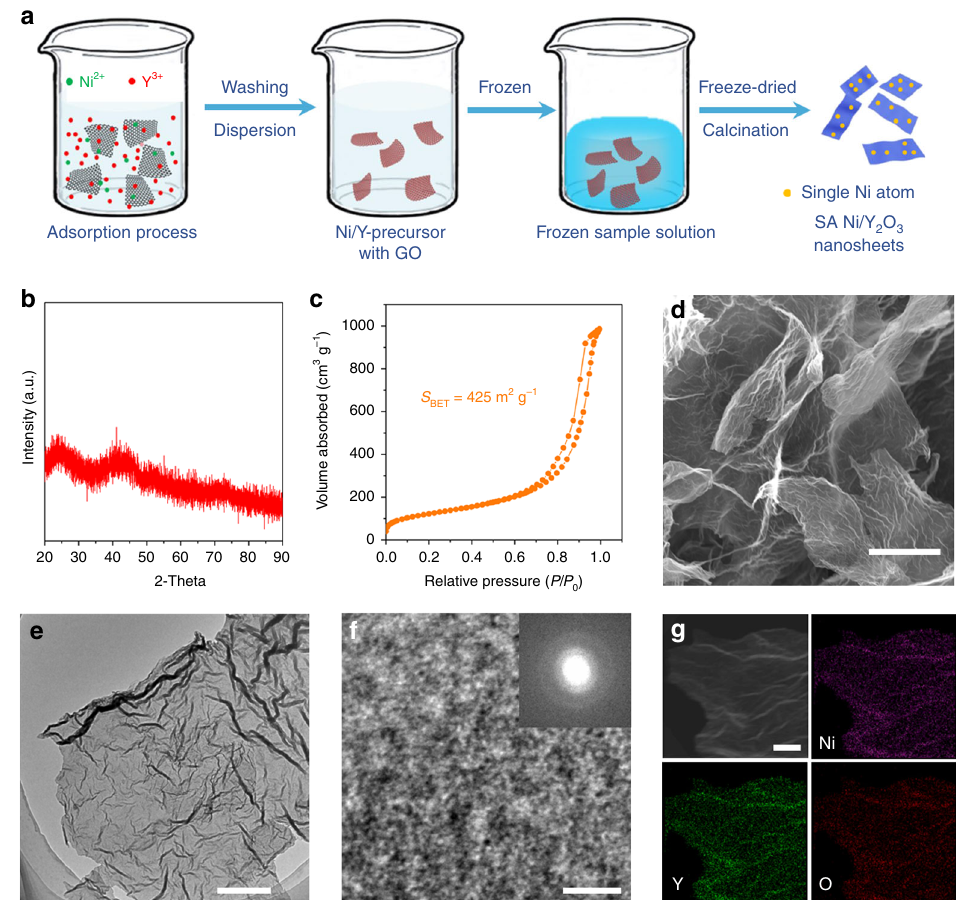
Fig. 2 Preparation and characterization of the SA Ni/Y 2 O 3 nanosheets. a Schematic of the preparation process for Y 2 O 3 nanosheets decorated with single Ni atoms (SA Ni/Y 2 O 3 ). b XRD pattern, c N 2 adsorption – desorption isotherm, d SEM image, e TEM image, f HRTEM image, g STEM image, and EDS mapping images of Ni, Y, and O of the SA Ni/Y 2 O 3 nanosheets. The inset in f is the corresponding electron diffraction pattern. The scale bars in d , e , f , and g are 1000, 200, 2, and 20 nm,